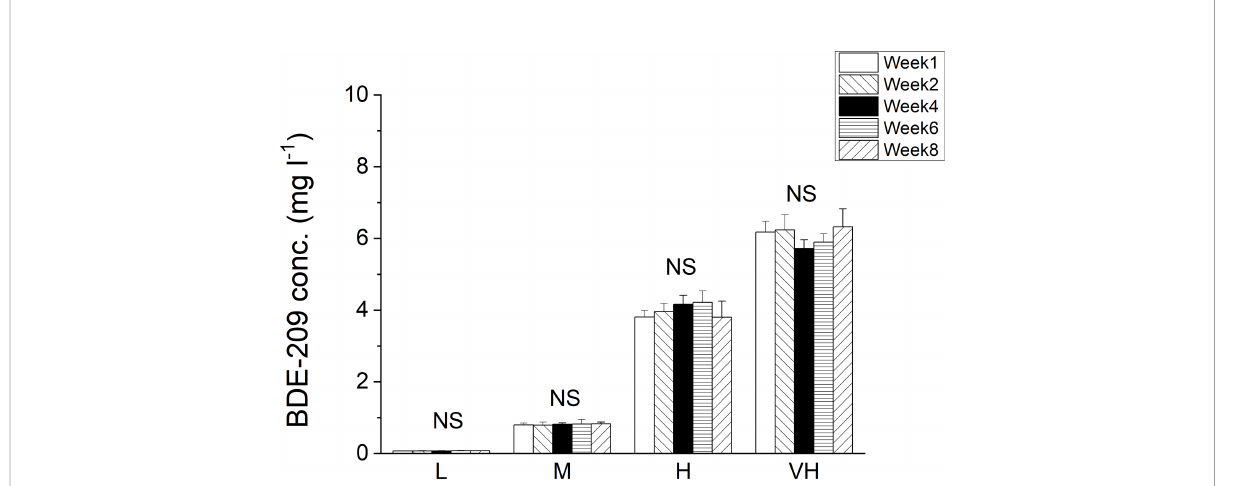
FIGURE 1 Concentrations of BDE-209 (mg l -1 ) remained in hydroponic culture solution under different contamination levels of BDE-209 (L: 0.1 mg l -1 BDE-209, M: 1 mg l -1 BDE-209, H: 5 mg l -1 BDE-209, VH: 10 mg l -1 BDE-209; NS: No signi fi cant difference among sampling times under the same treatment at p > 0.05 according to one-way ANOVA; Mean and standard deviation of three replicates are